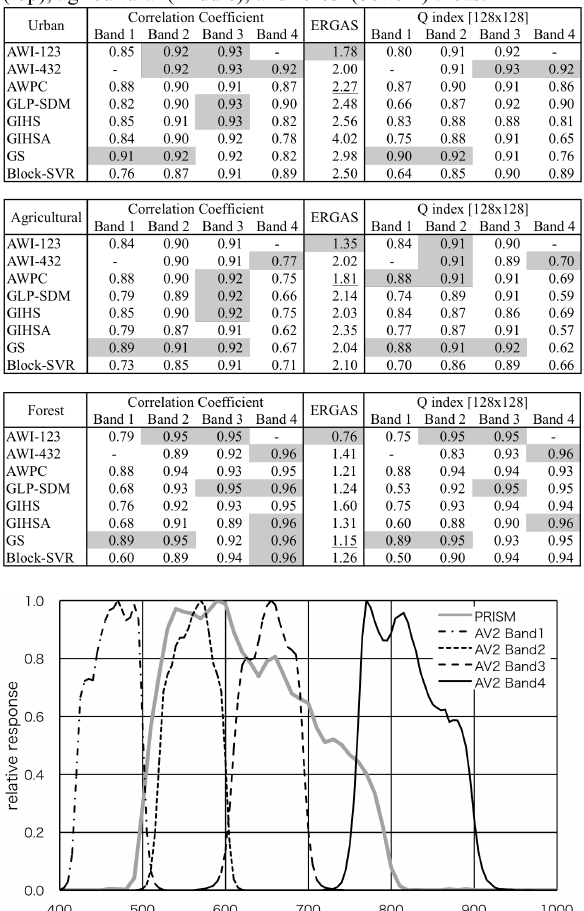
Table 2. Correlation coefficient, ERGAS, and Q index of urban (top), agricultural (middle), and forest (bottom) areas.